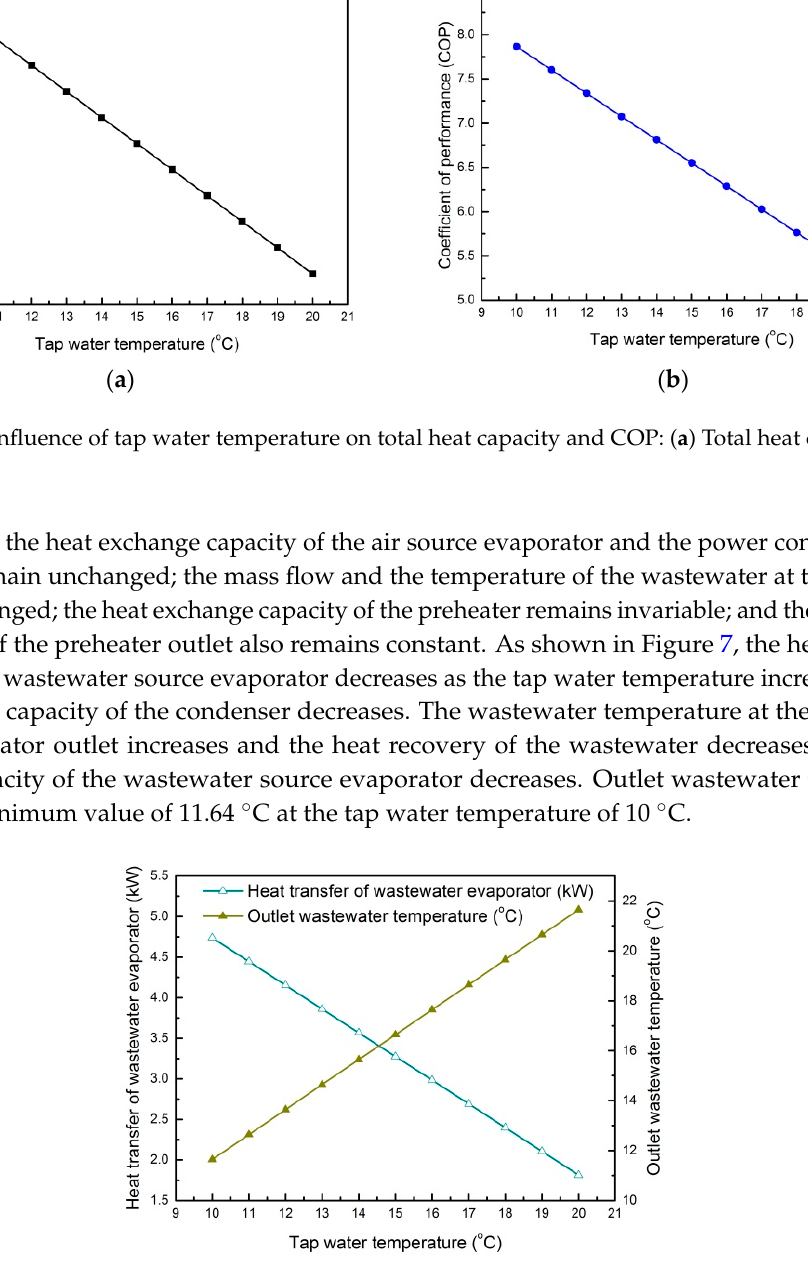
Figure 7. Influence of tap water temperature on heat transfer of wastewater evaporator and outlet wastewater temperature.